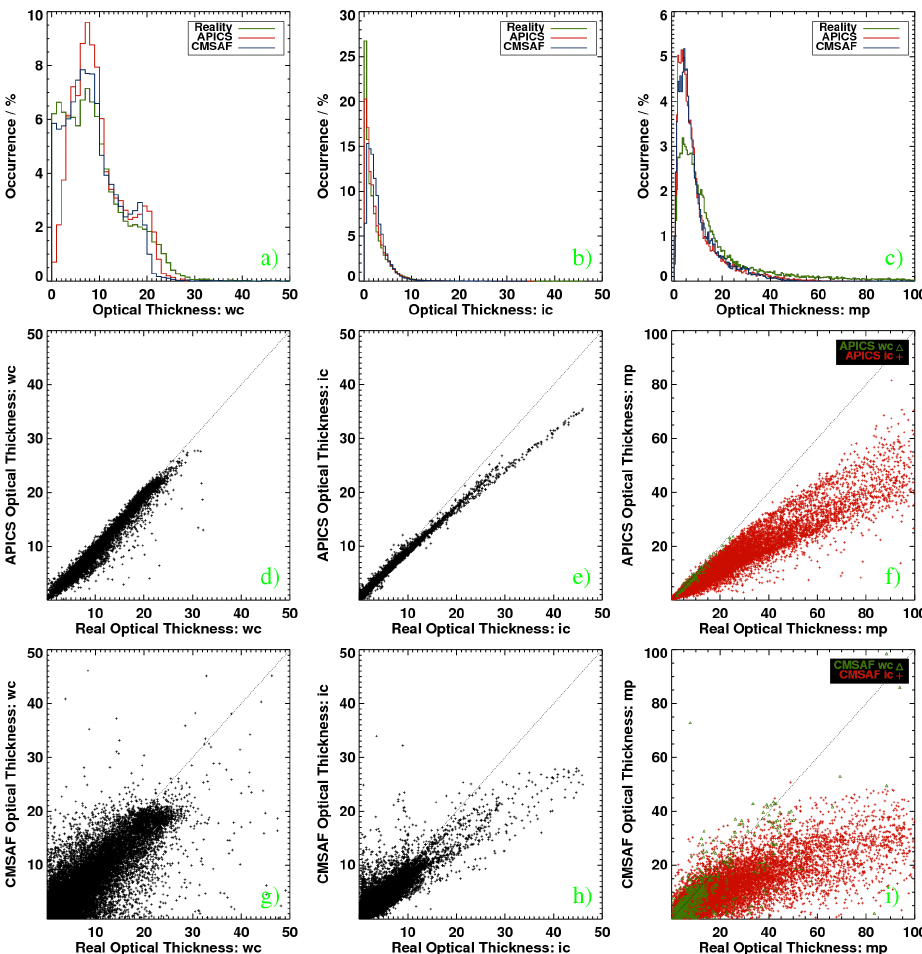
Fig. 10. Histograms and scatter plots of retrieved and real cloud optical thickness for both APICS and CMSAF. (a–c) Histograms of retrieved and real optical thickness of water, ice and multi-phase clouds for both APICS and CMSAF. (d–f) Scatter plots of APICS optical thicknesses against real optical thicknesses for water, ice and multi-phase clouds. (g–i) Scatter plots of CMSAF optical thicknesses against real optical thicknesses for water, ice and multi-phase